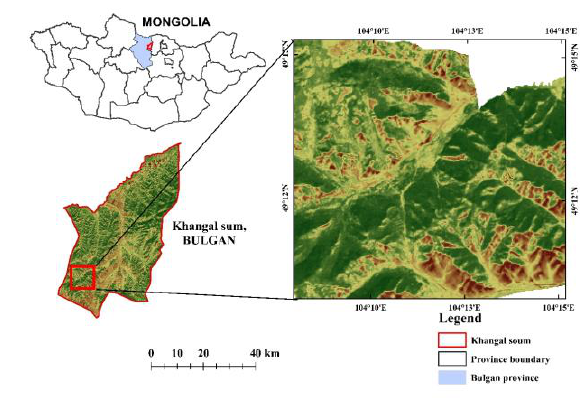
Figure 1. Study area of the southern side of Khangal sum (49° 11ʹ to 49°15ʹ N and 104° 8ʹ to 104° 15ʹ